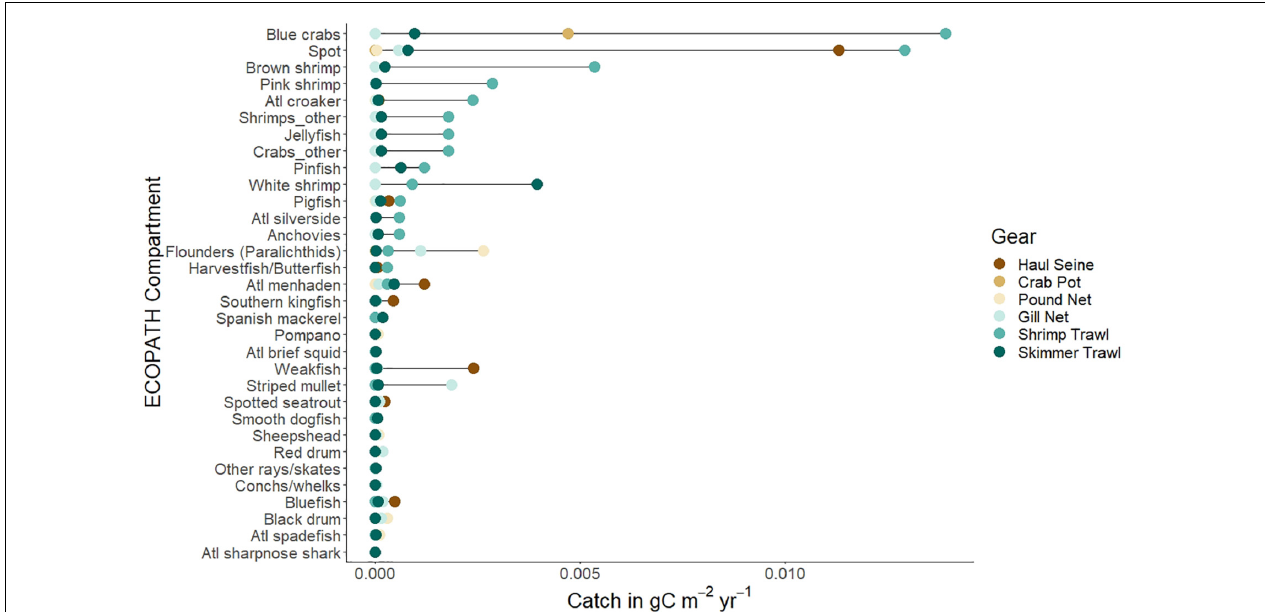
FIGURE 4 | The harvests of most common species (as included in ECOPATH open trawling management area model) in g C/m 2 /yr caught by six gear types (dark brown dots: haul seines; medium brown dots: crab pots; light brown dots: pound nets; light blue dots: gill nets; medium blue dots: shrimp trawls; dark blue dots: skimmer trawls) from Core Sound, North Carolina as reported to the NCDMF in 2007. Species arrangement is rank order observed in shrimp trawls, the dominant fishing gear in terms of biomass